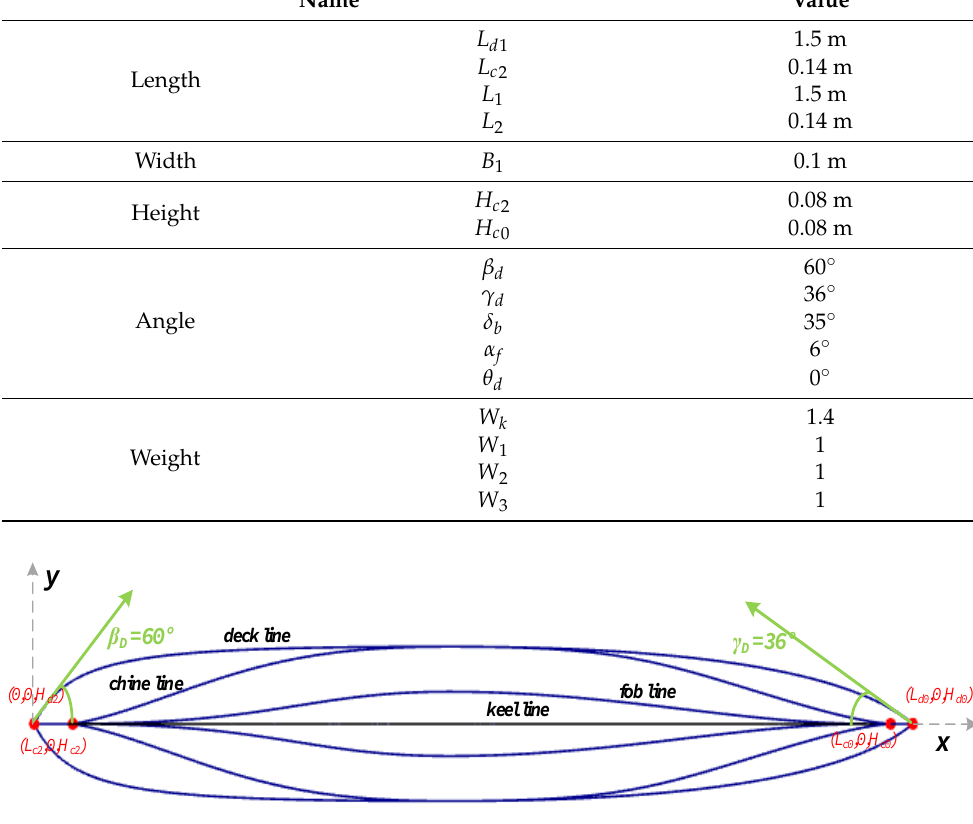
Table 6. Combination of parameters as constraints.